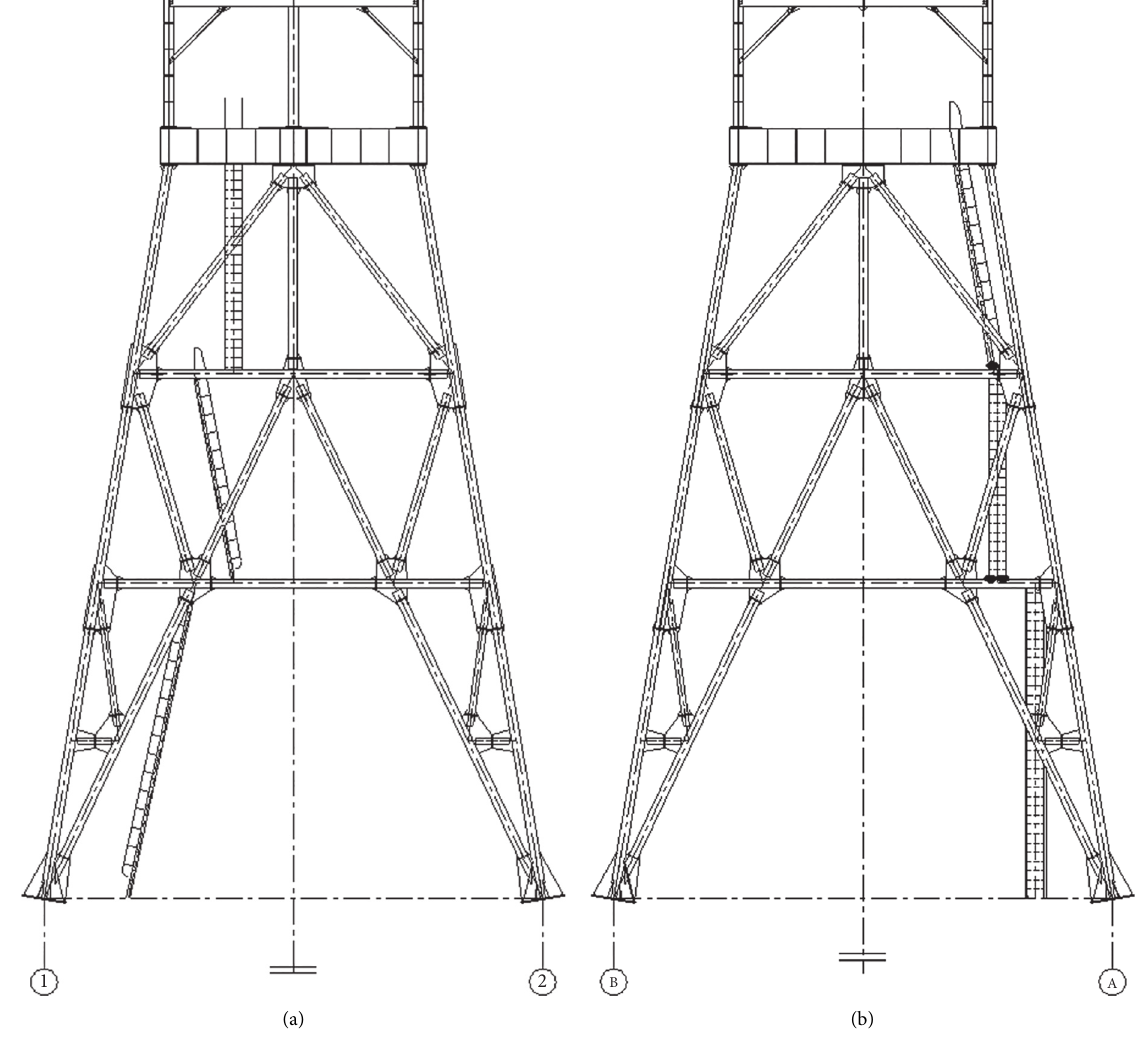
Figure 1: General drawing of SA-III sinking headframe. (a) Front elevation of headframe. (b) Side elevation of